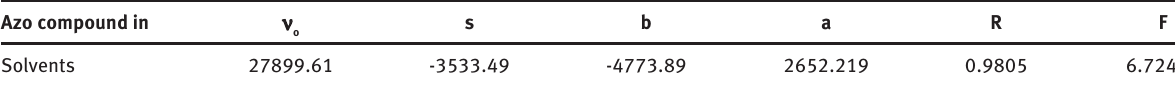
R – correlation coefficient; F – Fisher’s test.